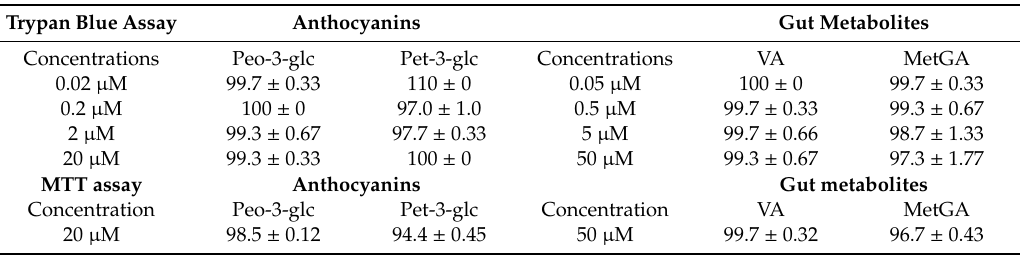
Table 1. Percentage of cell viability following supplementation with peonidin-3-glucoside (Peo-3-glc), petunidin-3-glucoside (Pet-3-glc), vanillic acid (VA) and methyl-gallic acid (MetGA) evaluated by Trypan blue and MTT assays.